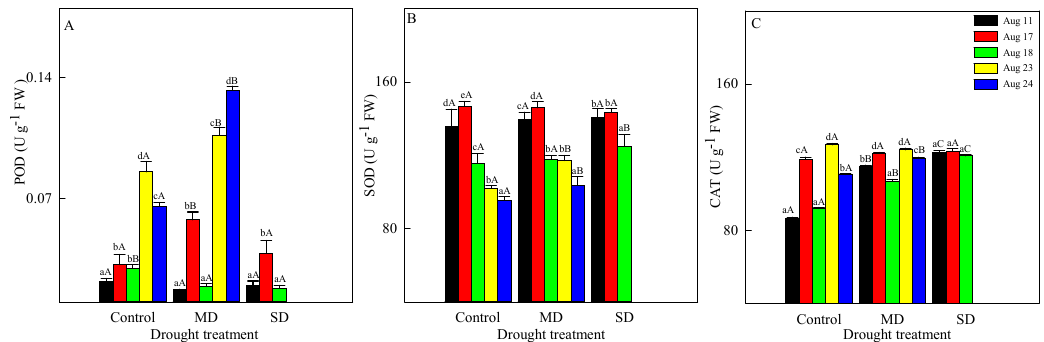
Figure 3. Changes in ( A ) peroxidase (POD), ( B ) superoxide dismutase (SOD), and ( C ) catalase (CAT) activity of A. halodendron under drought and in the rehydration phase. Values represent mean ± SE. Bars labelled with different lowercase letters represent significant differences among days for a given treatment. Bars labelled with different capital letters differ significantly among drought treatments on a given day. 11, 17 and 23 August 2018 correspond to drought, 18 and 24 August 2018 correspond to rehydration.